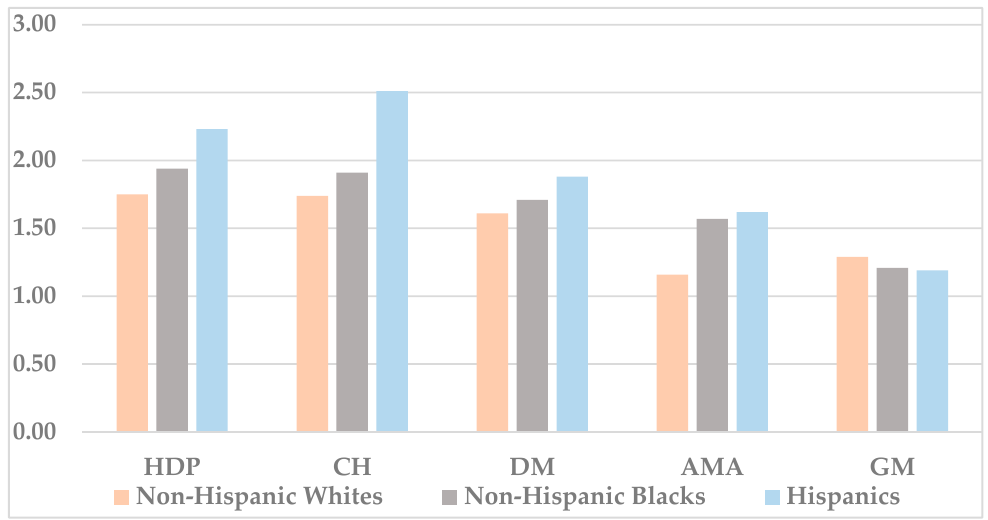
Figure 2. Temporal changes in the prevalence of the pregnancy risk factors/complications between 2007 and 2018, by racial/ethnic group (presented as odds ratios). All of the differences between the racial/ethnic groups are statistically significant ( p < 0.001).